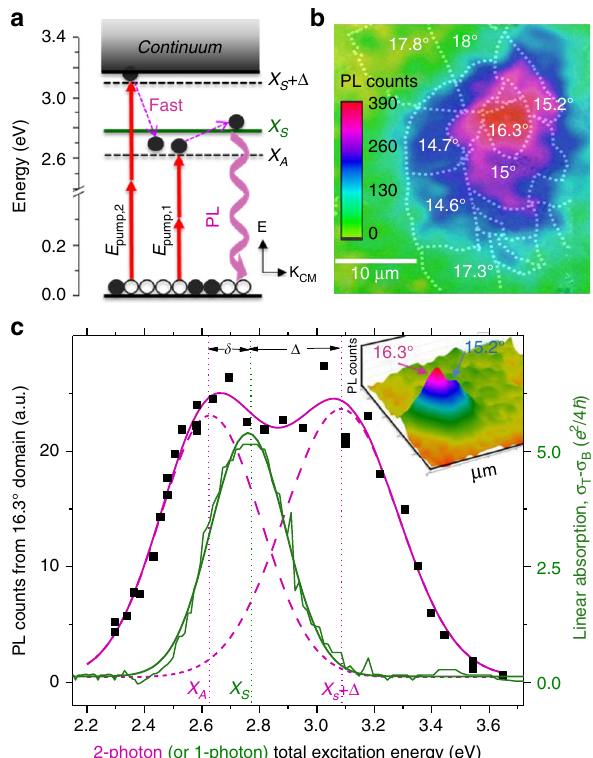
Fig. 3 Interlayer exciton binding energy and PLE spectra. a Exciton model diagram showing emission of the X S state after 2-photon excitation of X A or continuum edge state, X S + Δ . b Spatial PL map of CVD t BLG shows enhanced emission from the 16.3° domain and adjacent spectrally overlapping 15.2° domains after 2-photon excitation at 2×1.3eV. c Extended range 2-photon PLE spectrum (black squares) fi ts to bimodal Gaussian peaks straddling the 1- photon linear absorption spectrum (green line). The total peak splitting δ + Δ , suggests E b ≅ 0.5eV. (Inset) 3D PL map showing ~5× PL resonant enhancement of the θ = 16.3°